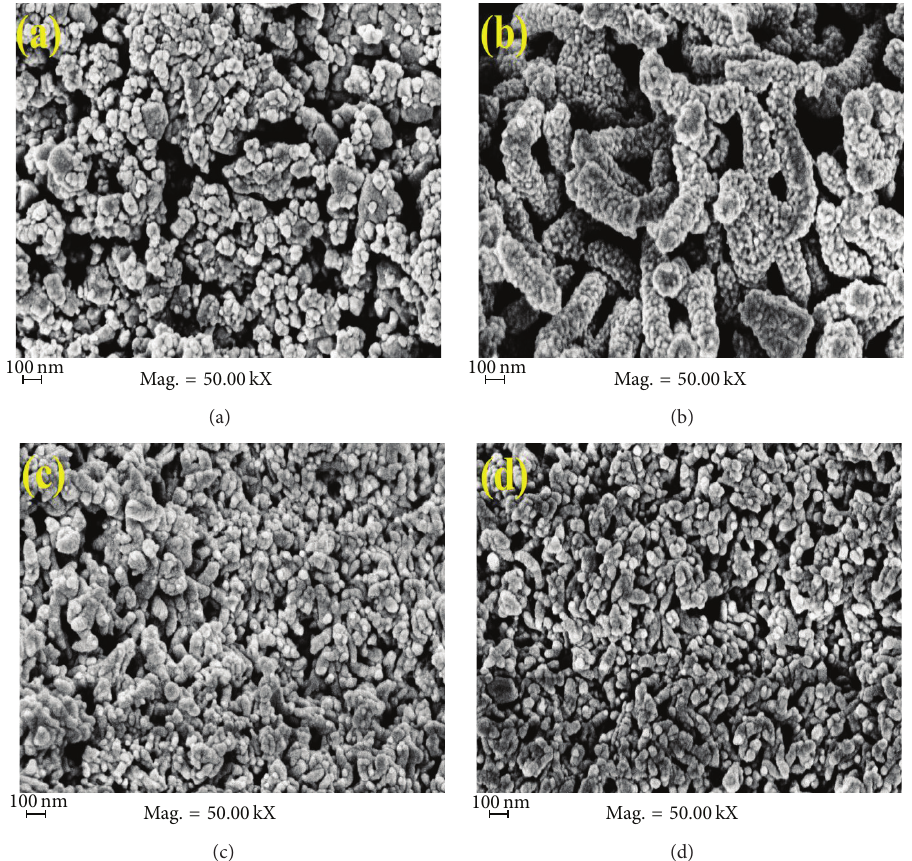
Figure 2: FESEM photographs of (a) TiO 2 particles, (b) TiO 2 /PANi, (c) TiO 2 /C, and (d) TiO 2 /AC, respectively.